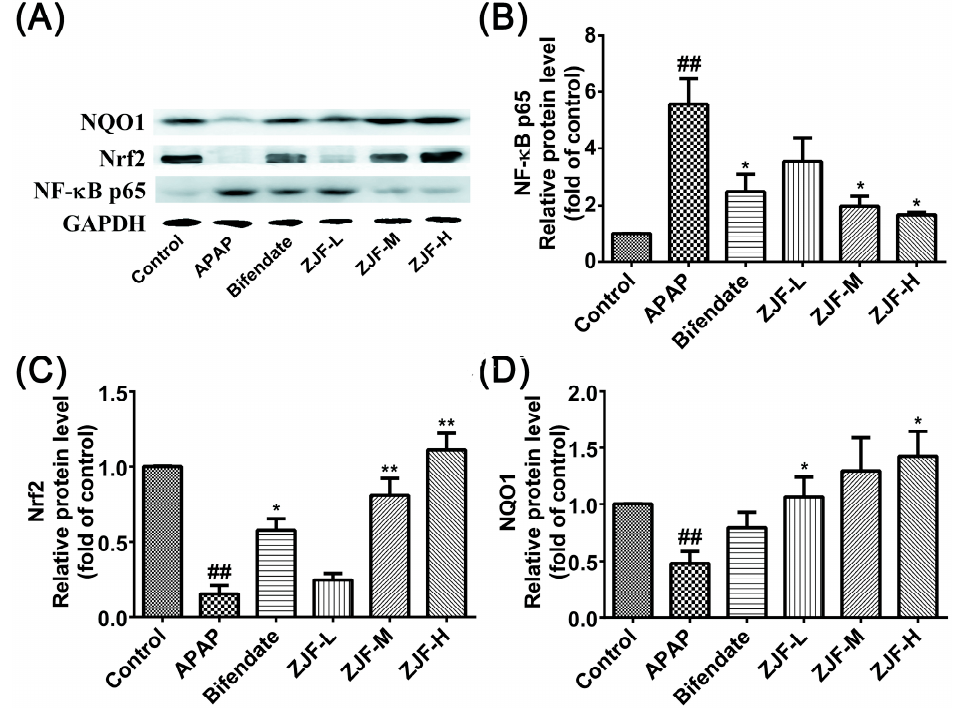
Figure 6. The effect of ZJF pretreatment on the nuclear factor kappa B p65 (NF- κ B p65), nuclear factor erythroid 2-related factor 2 (Nrf-2), and NAD(P)H: quinone oxidoreductase 1 (NQO1 ) protein expression in response to the APAP-induced hepatotoxicity. ( A ) Western blotting analyses of NF- κ B p65, Nrf-2, and NQO1 proteins; quantitative densitometric analyses of ( B ) NF- κ B p65, ( C ) Nrf-2, and ( D ) NQO1 proteins normalized against glyceraldehyde-3-phosphate dehydrogenase (GAPDH). Each value represents the mean ± SEM of three independent experiments. ## p < 0.01 vs. the control group. * p < 0.05 and ** p < 0.01 vs. the APAP treated group.